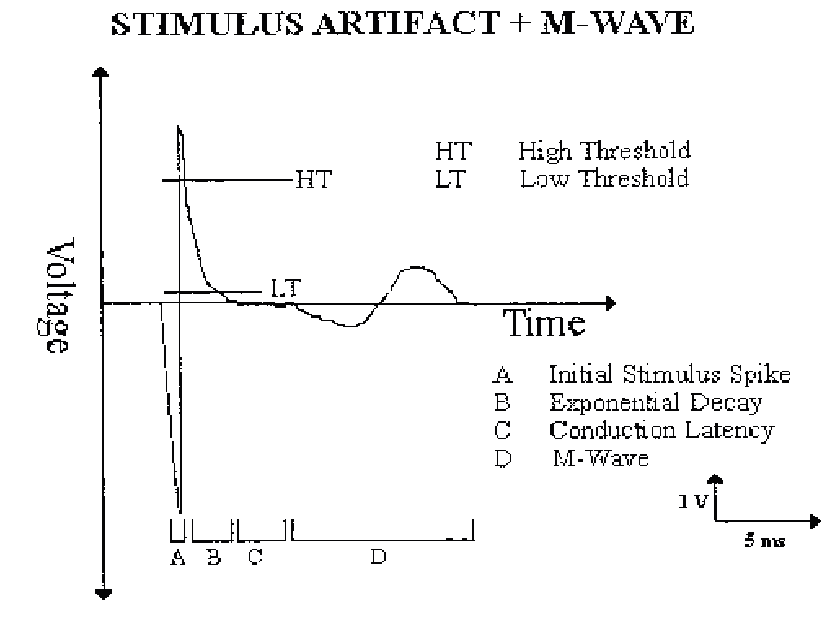
Figure 6. An example of the effect of stimulation artefact on evoked EMG (M-wave)